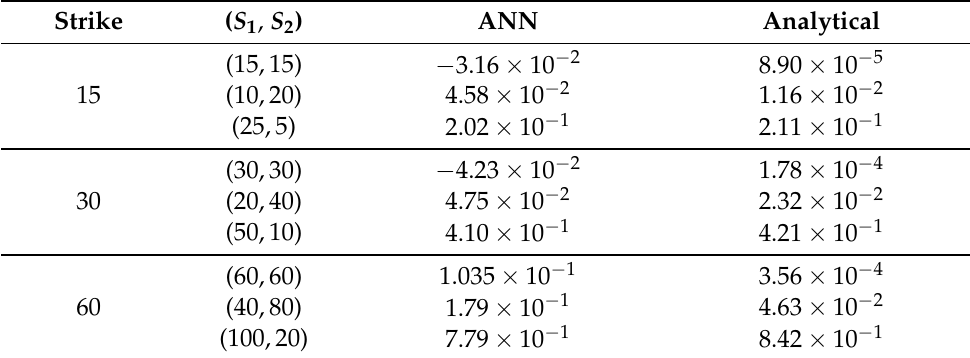
Table 5. European max-call option value.